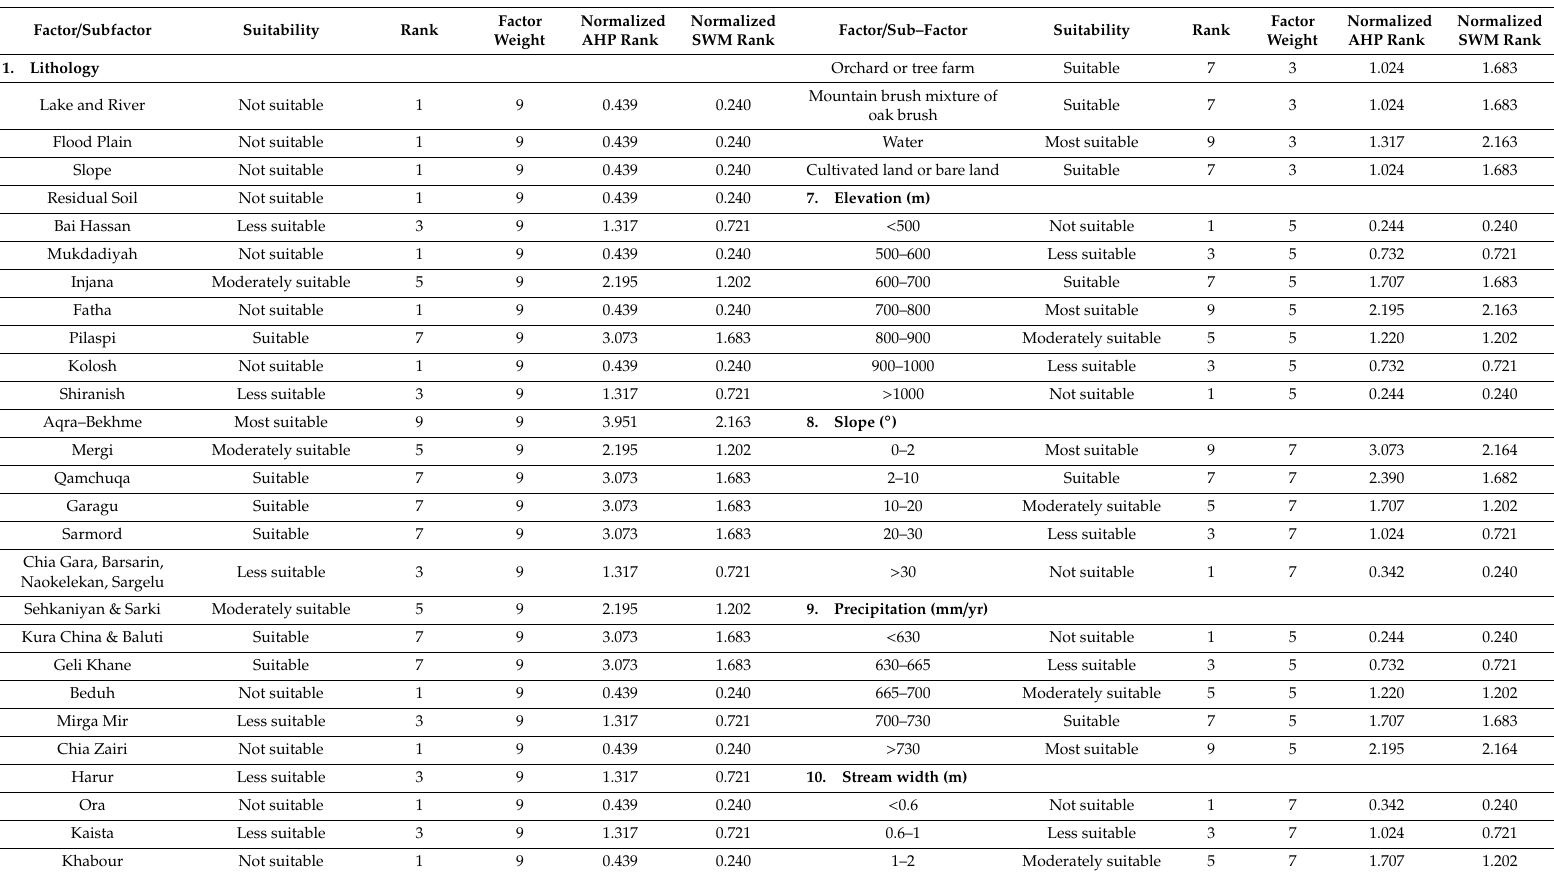
Table A3. Decision rules for used factors and finalized weights of criteria obtained from WSM and AHP